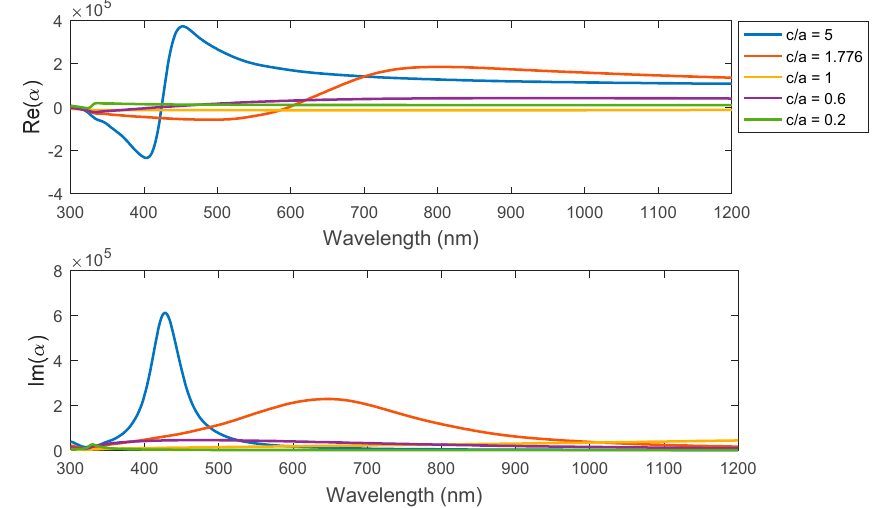
Figure 5. The real and imaginary parts of polarizability with different aspect ratios (c/a) for the studied elliptical geometries.